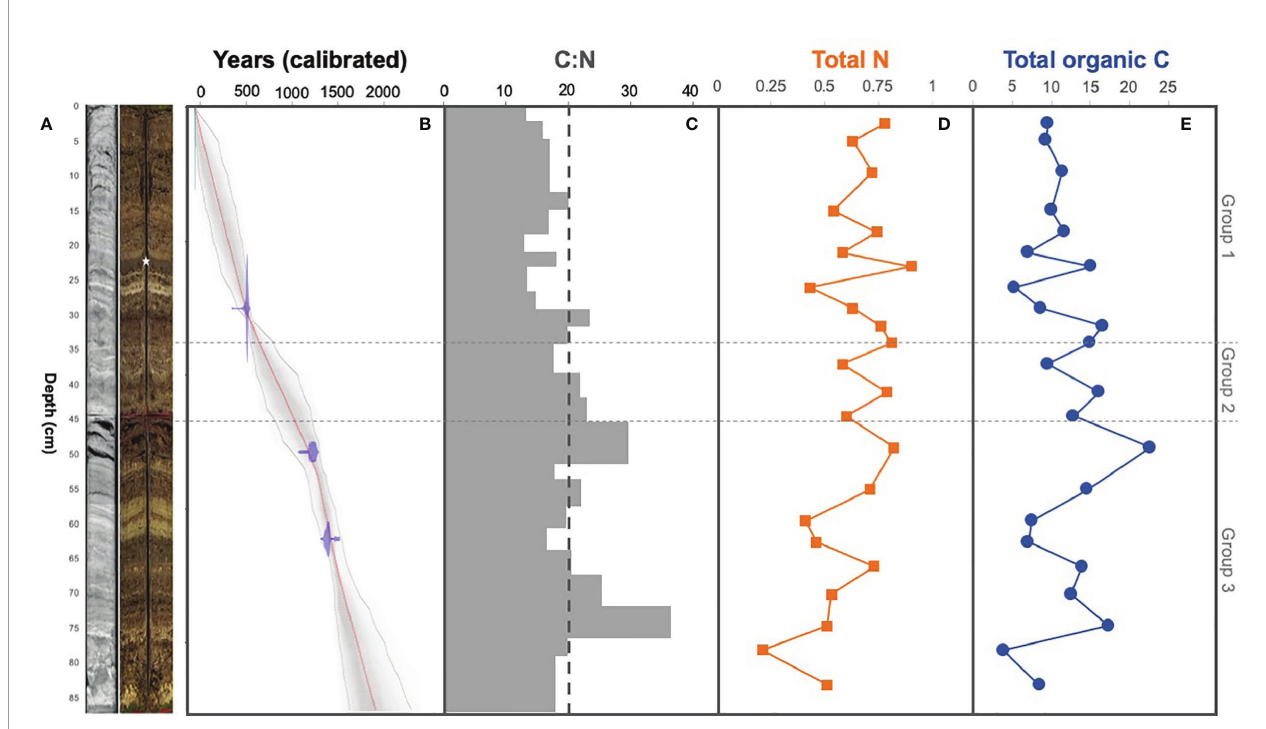
FIGURE 2 | (A) Radiograph and picture of core BLWD-C7. The white star indicates the sapropel layer that is synchronous across all cores from Blackwood Sinkhole. (B) Downcore age model for BLWD-C7 showing core to be up to ~1900 years old. Radiocarbon results were calibrated into calendar years before present (present being 1950) with IntCAL13 and visualized using Bacon v2.2. The calibrated 14 C dates are shown in the transparent blue regions, the grey coloring indicates more likely calendar ages, and the red line shows the best model based on the weighted mean age for each depth. (C) C:N ratio based on the percentage of (D) total nitrogen (%) and (E) total organic carbon (%), in accordance to depth in